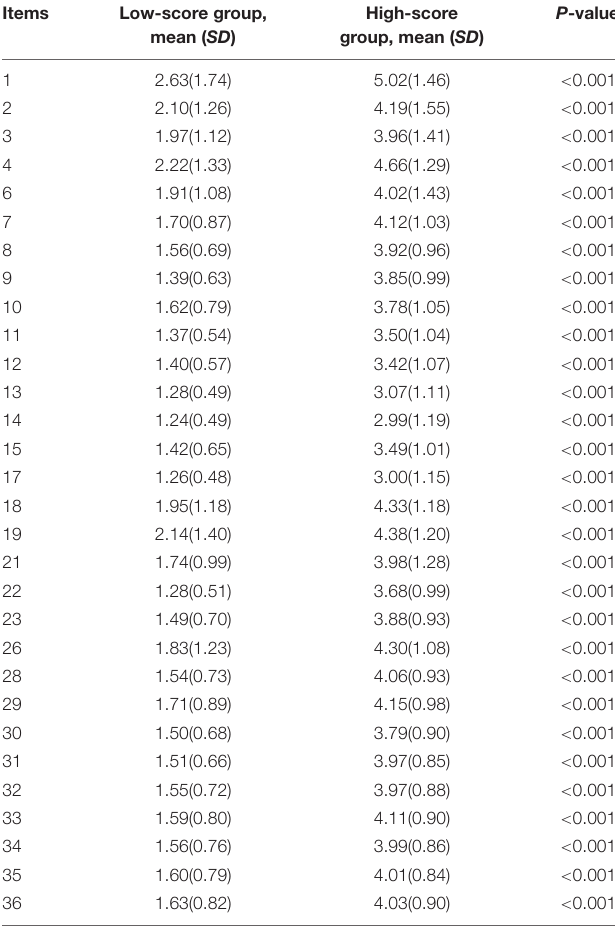
TABLE 8 | Score comparison between high-score and low-score groups ( N = 1870).